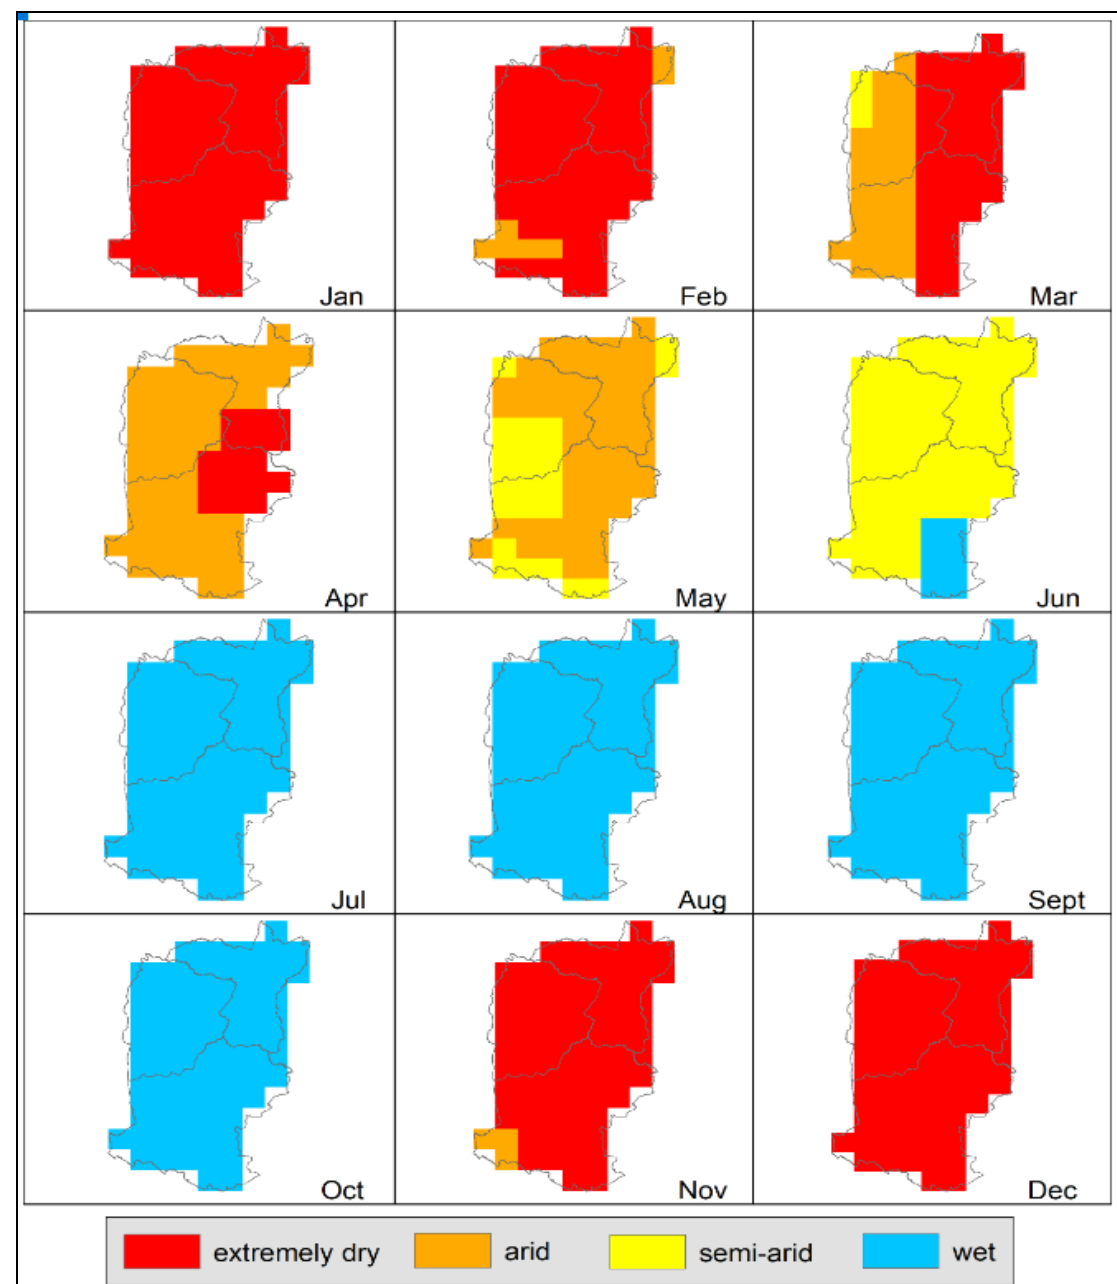
Figure 10. Thornthwaite aridity index map for 2015.